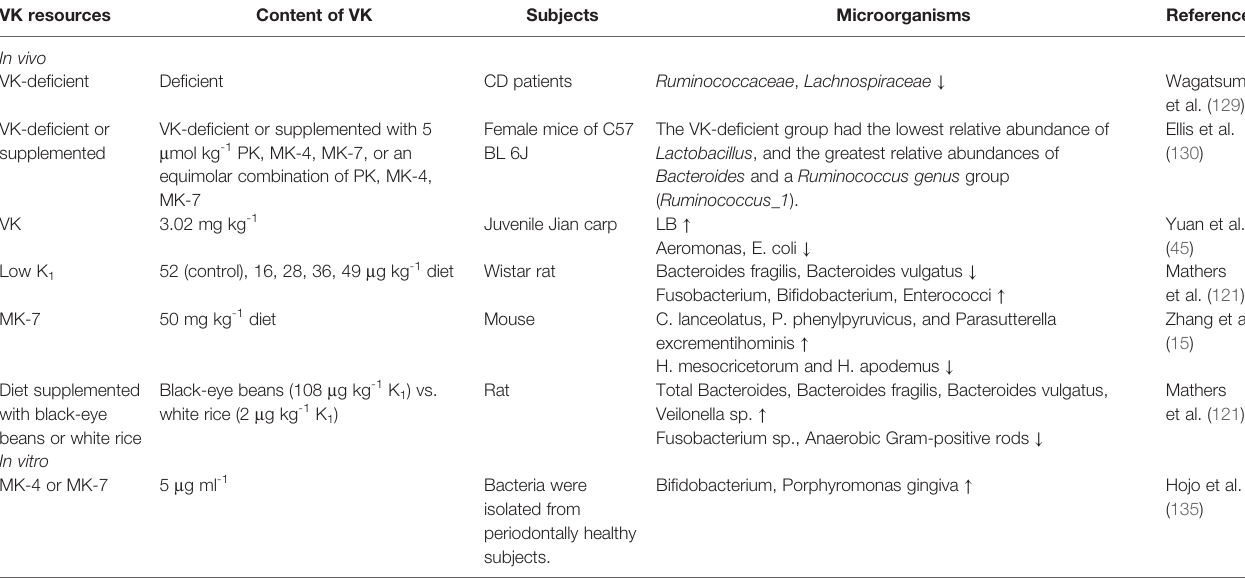
TABLE 2 | Pro fi le of gut microbiota after supplementation or de fi ciency of VK in vivo and effect of VK on micro fl ora in vitro